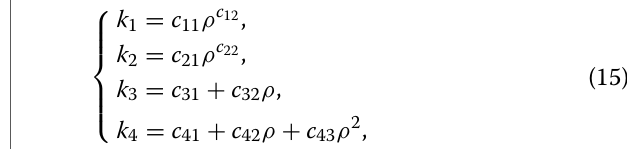
Figure 5 β versus B / D